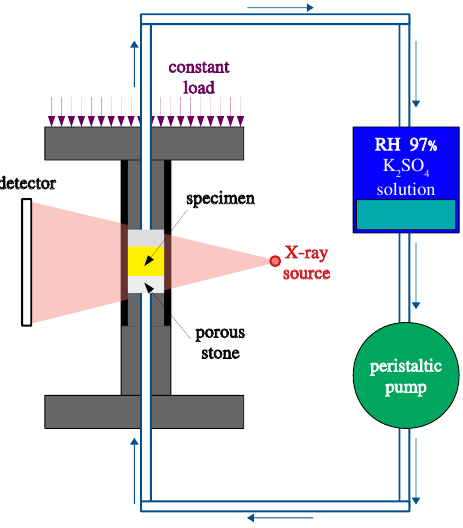
Figure 1. Experimental set-up used for this experimental cam- paign. Couscous grains were placed in an oedometer, under a dead load of 20kPa. They were constantly exposed to high rela- tive humidity air, generated in a humidity control chamber con- taining a potassium sulphate saturated solution (RH = 97%) and pumped at 15mL / min with a peristaltic pump.